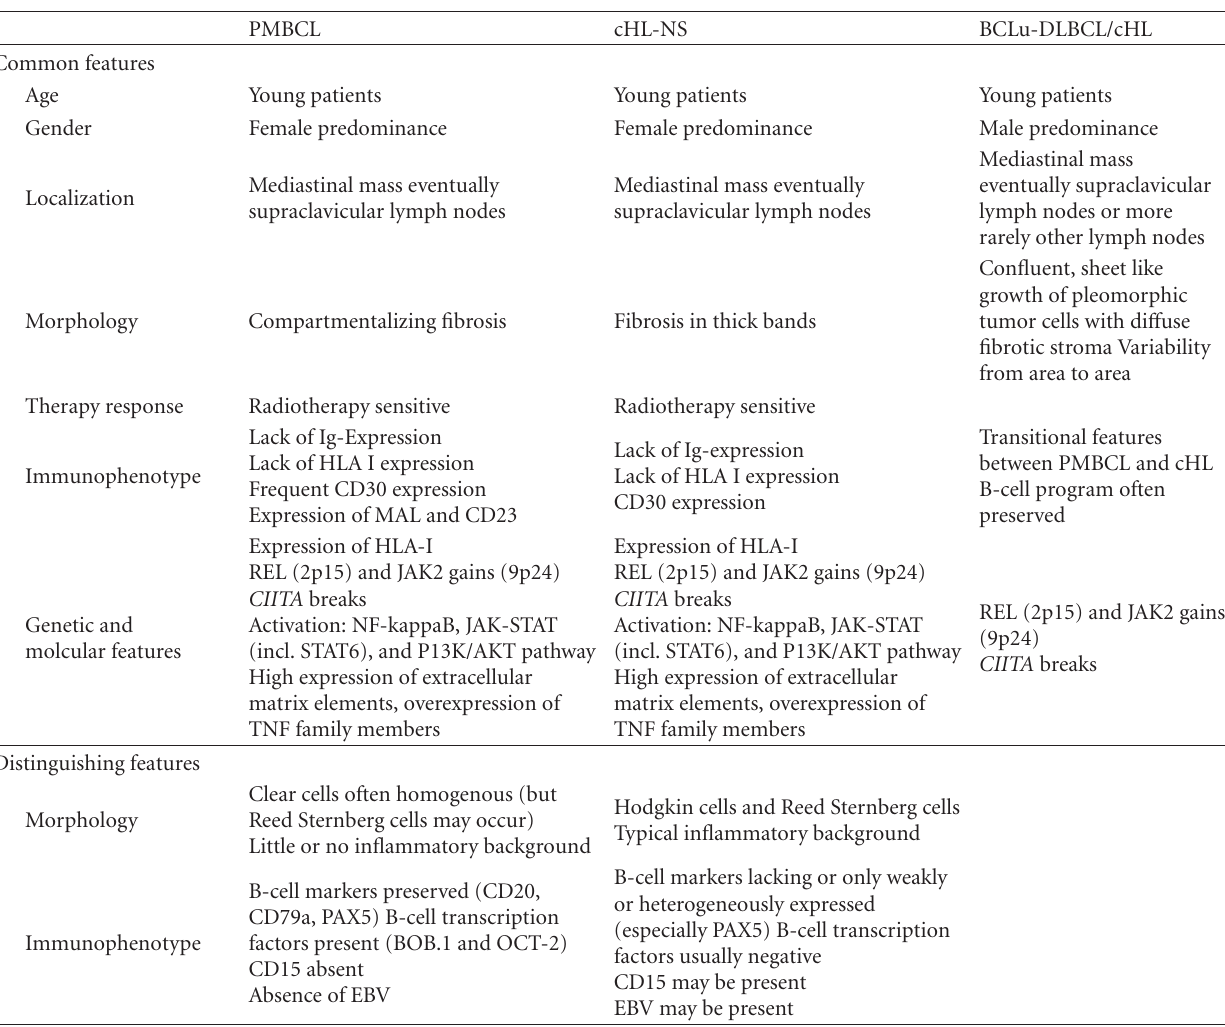
Table 1: Common and distinguishing features of PMBCL, cHL-Nodular sclerosis (NS), and B-cell lymphoma, unclassifiable, with features intermediate between DLBCL and cHL (BCLu-DLBCL/cHL). Modified after Hasserjian et al.